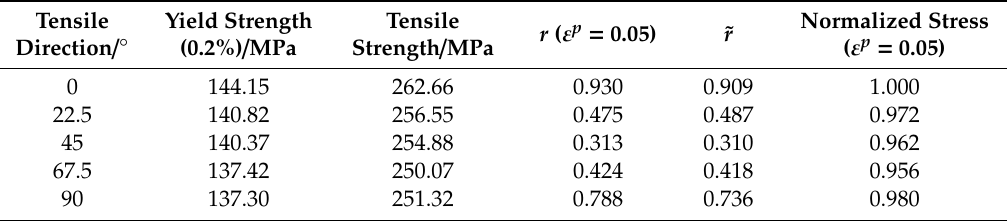
Table 1. Properties of the A6116 specimen.